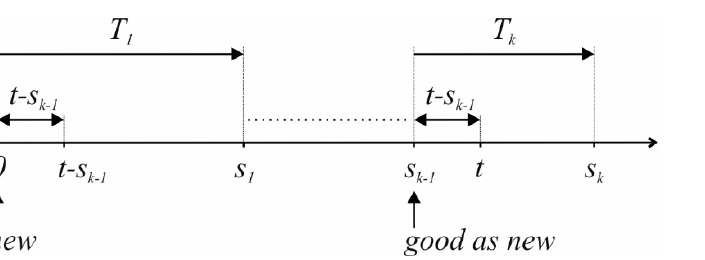
Figure 2. Assuming that the FBM restores the system to an as-good-as-new state, it holds that all renewal cycles are equivalent; i.e., 𝑇 (cid:3036) = 𝑇 (cid:3037) = 𝑇 for all 𝑖, 𝑗 ∈ N .